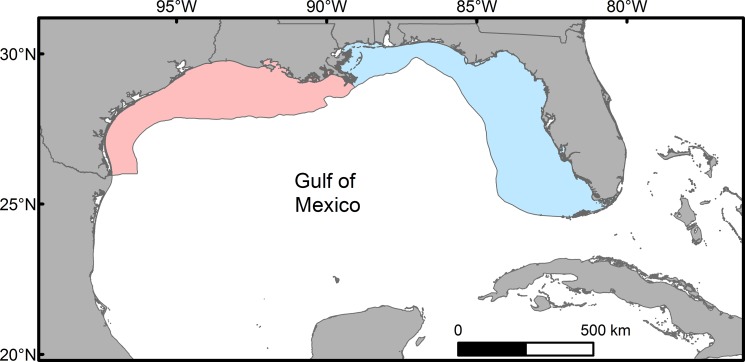
Shelf waters (< 150 m) of the U.S. Gulf of Mexico.The eastern Gulf of Mexico is shown in blue, while the western Gulf of Mexico is shown in red.